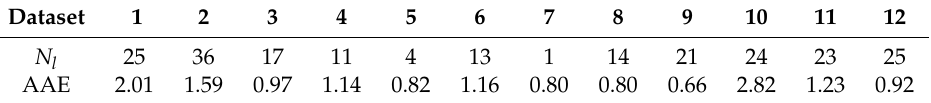
Table 3. AAE values obtained by performing motion artifact removal using the linear filter.